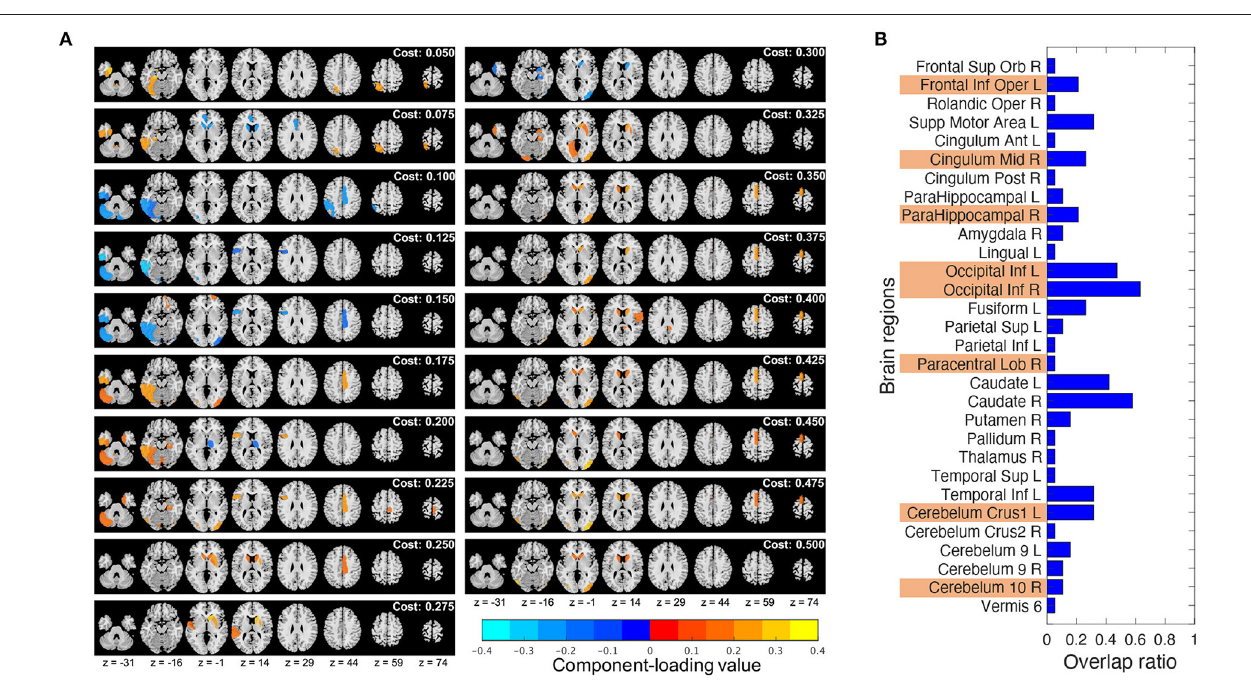
FIGURE 6 | Comparison of the T3Clus results between different network thresholds (from 0.050 to 0.500, increments: 0.025). (A) Component loading maps at different thresholds (referred to as “cost” in the figure). (B) Overlap ratio of the chosen brain regions among 19 different cost values. Orange colored ones are the eight regions extracted at cost =